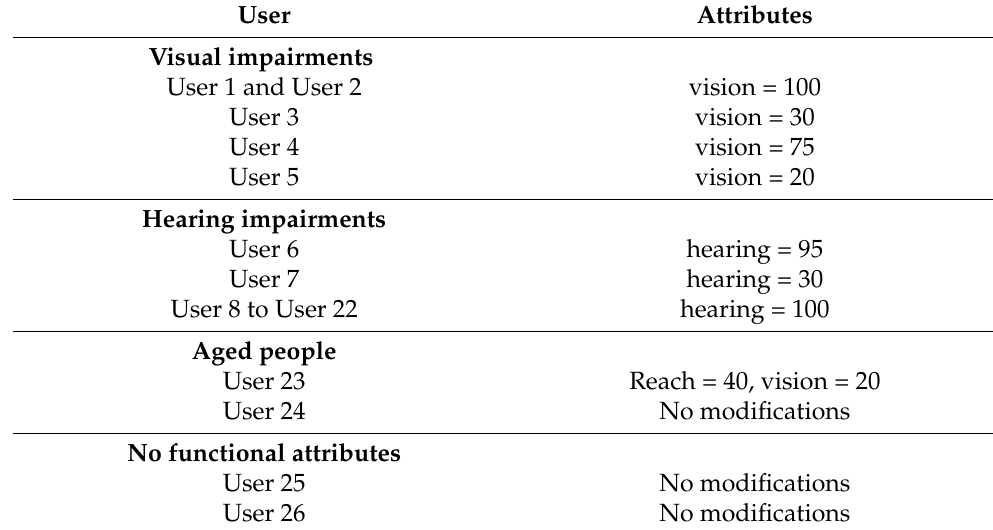
Table 7. Users and